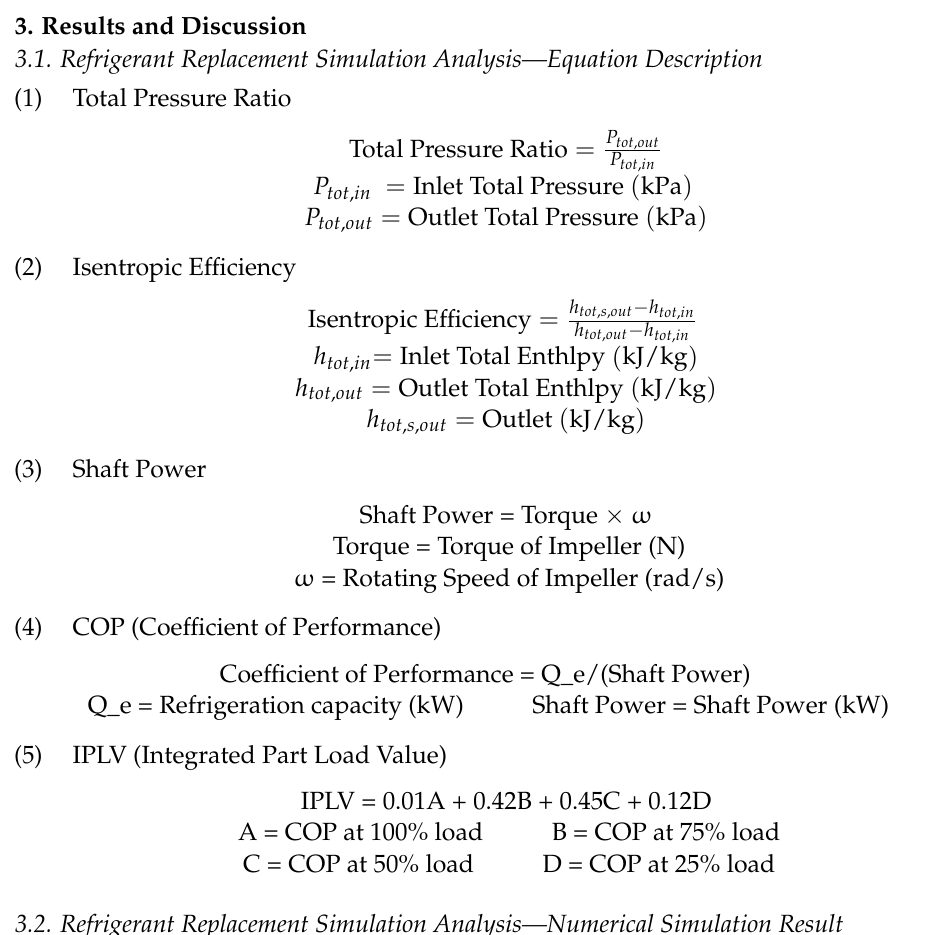
Figure 10. Comparison chart of simulated shaft power and experimental electric power .